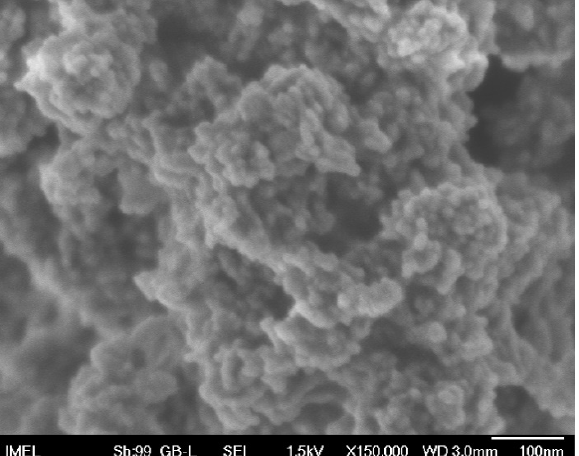
Figure 1. SEM image of the CuO nanopowder selected to be used as the nanofiller for the PMMA composites. Magnification: ×150,000; Scale bar: 100 nm.